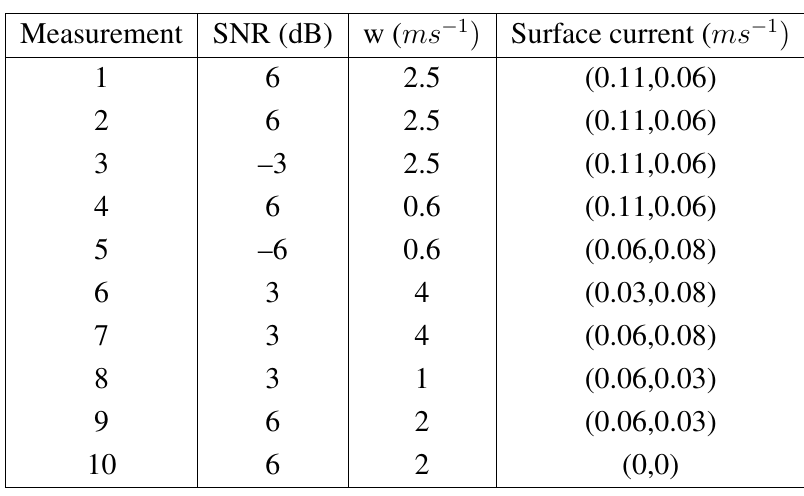
Table 2. Parameters used in the